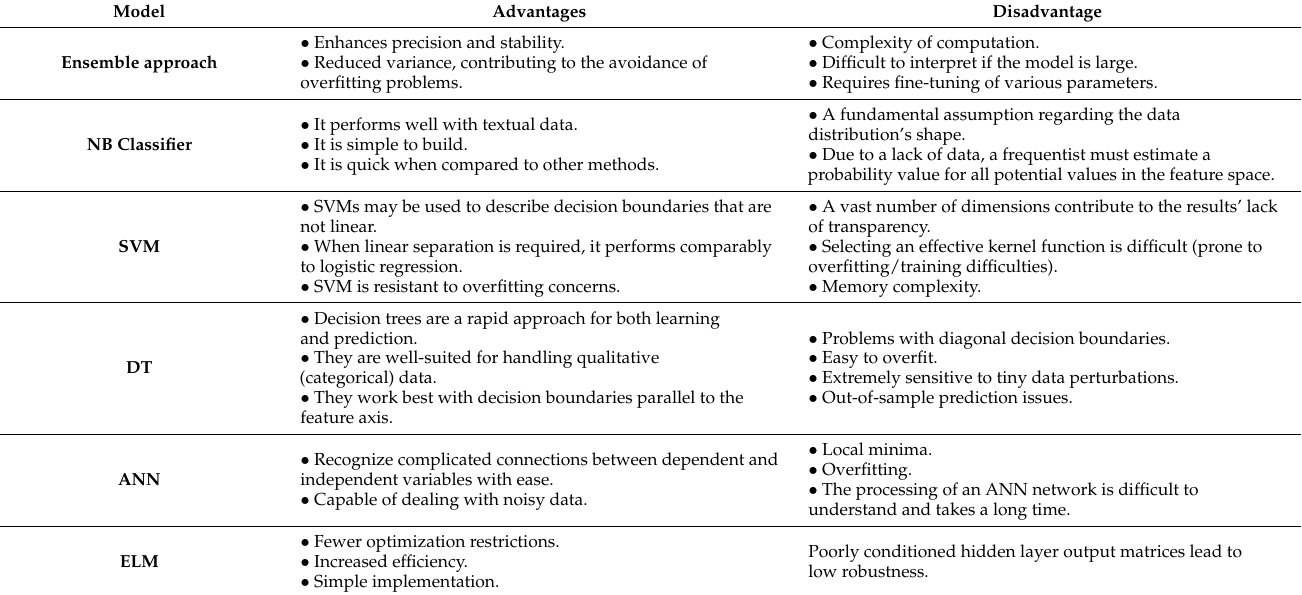
Table 2. Comparison of classification algorithms [50].